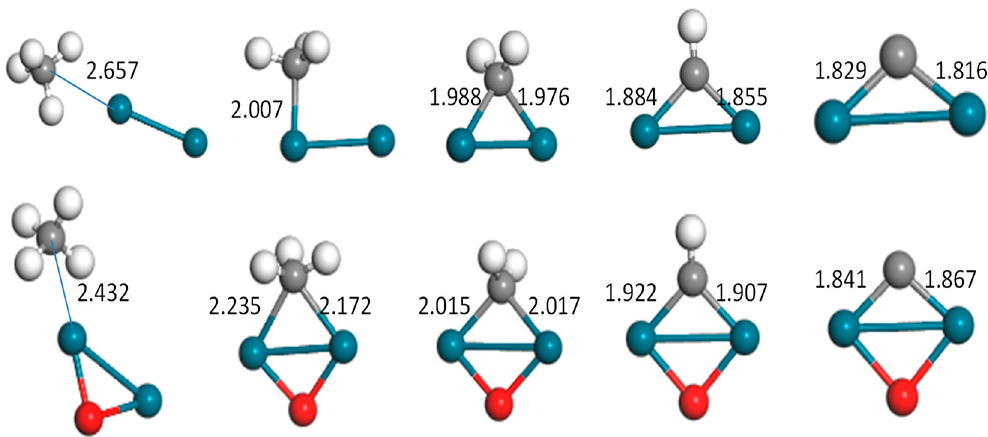
Figure 2. Optimized configurations of the CH x –Pd 2 (o) (x = 0–4) system (bond unit, Å; turquoise: Pd, gray: C, white: H, red: O). Table 1. Binding energies of CH x (x = 0–4) adsorbates on dimer Pd 2 and trimer Pd 2 O.